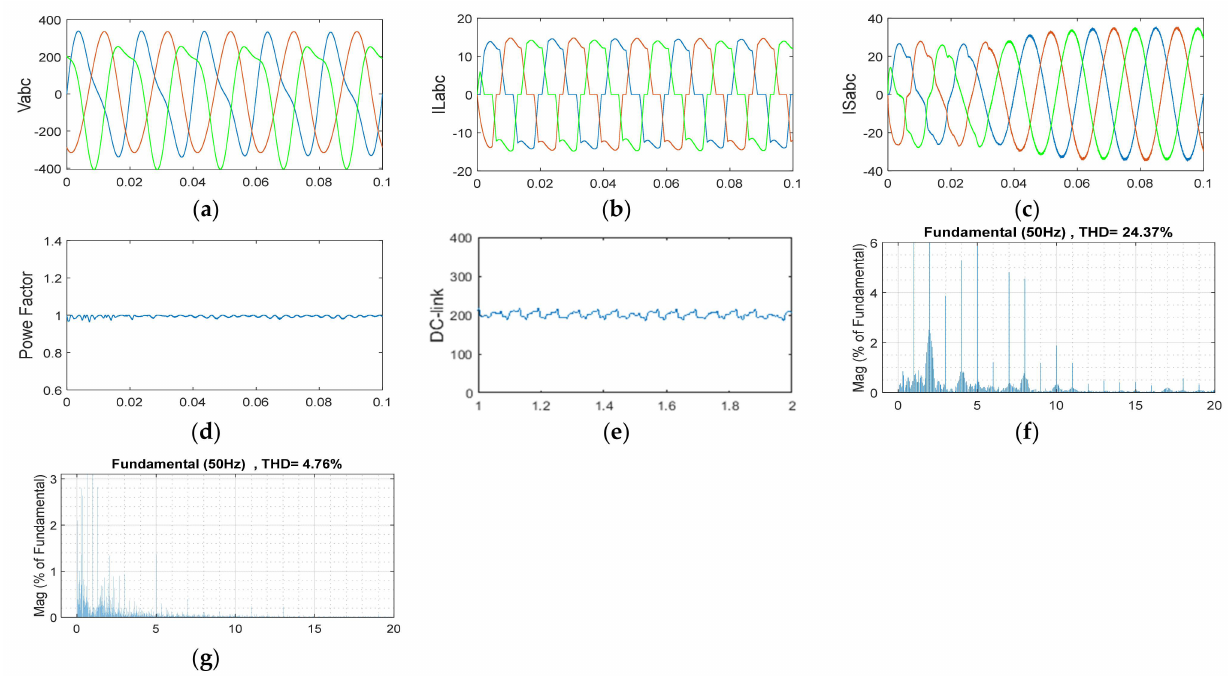
Figure 10. The simulation results of proposed algorithm in Section 3.3: ( a ) Unbalanced and non- sinusoidal 3-phase voltage source; ( b ) 3-phase source current before mitigation; ( c ) 3-phase source current after mitigation; ( d ) power factor; ( e ) DC-link voltage; ( f ) THD for load current; ( g ) THD for line